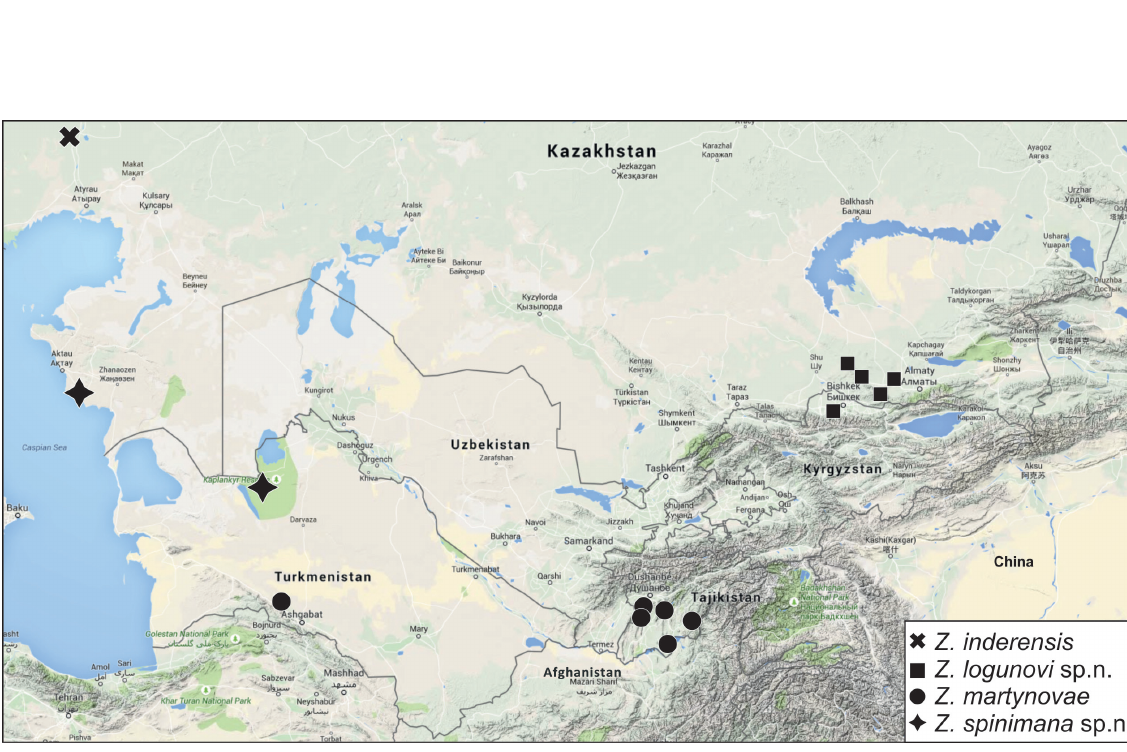
Fig. 48. Distribution of Zaitunia logunovi and Zaitunia martynovae species groups.